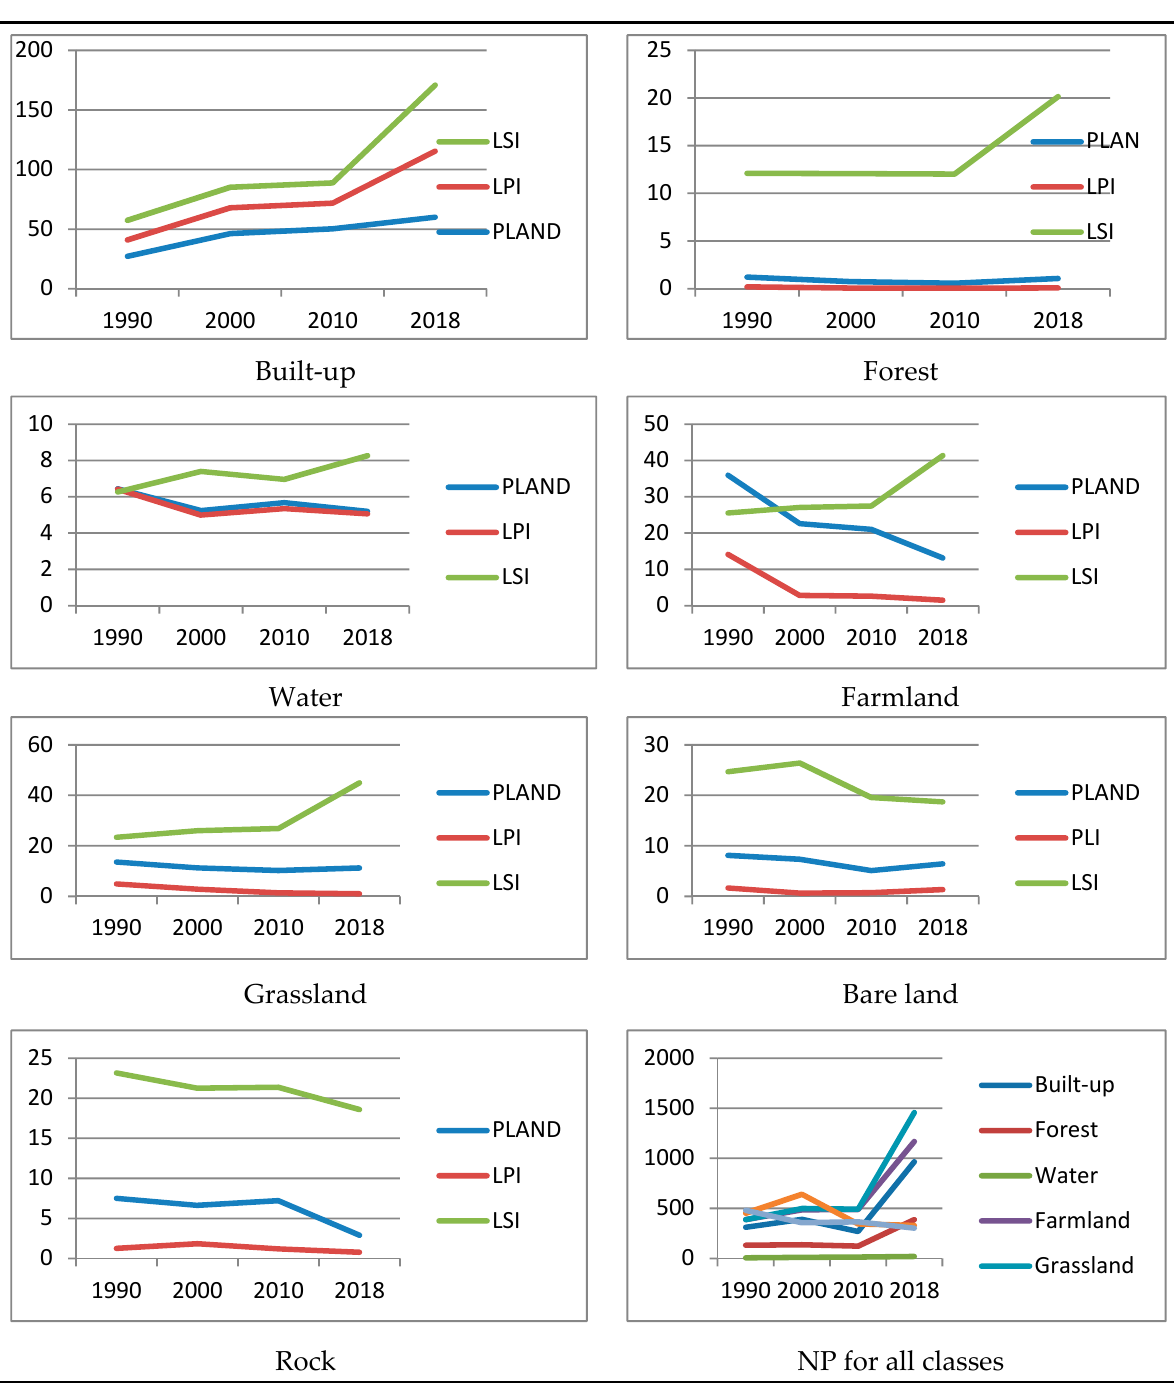
Figure 5. Curves of index trends at class level.